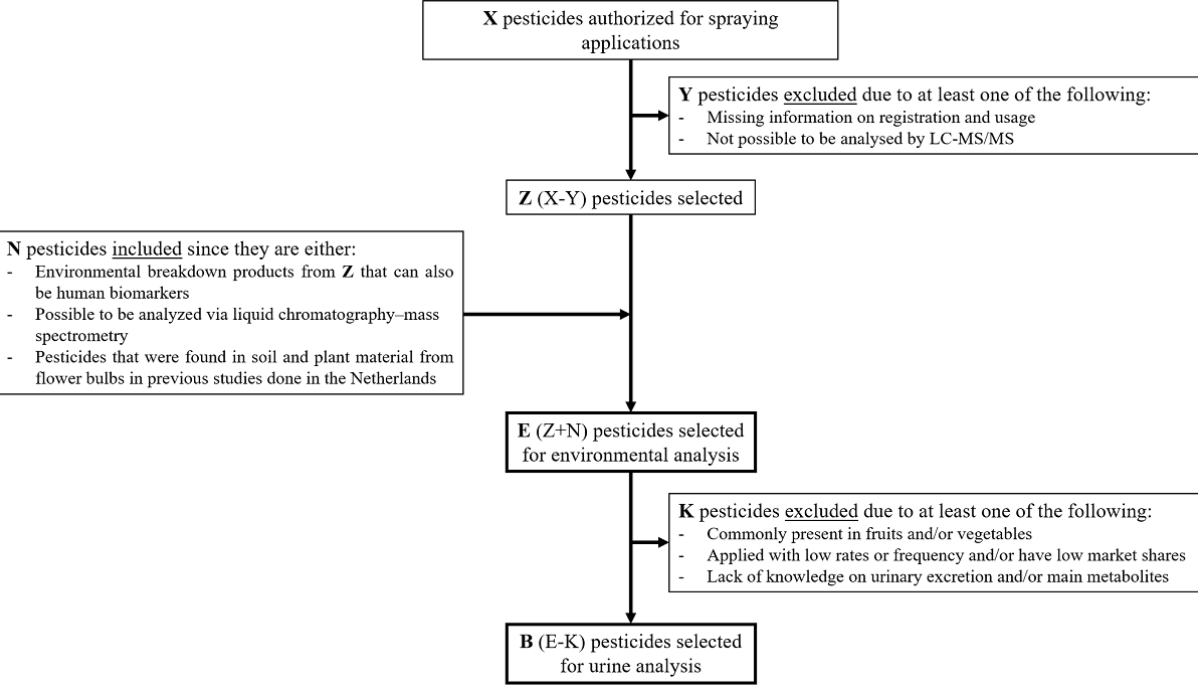
Figure 2. Inclusion and exclusion criteria used in the selection of pesticides to be analyzed in environmental and urine samples. LC-MS/MS: liquid chromatography with tandem mass